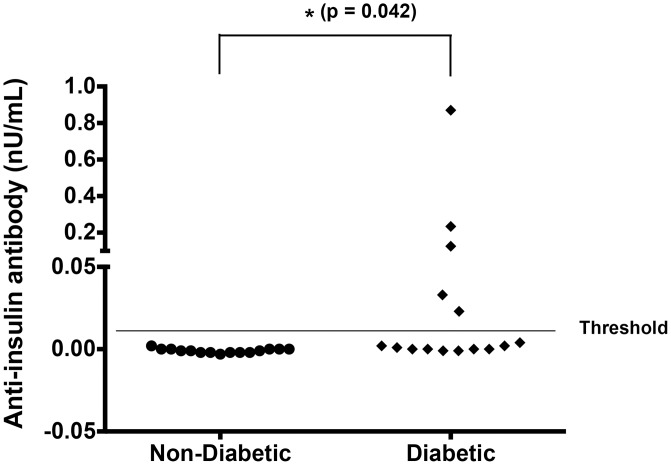
Anti-insulin antibodies in diabetic and non-diabetic dogs.Anti-insulin antibodies were measured using the microIAA radioassay. Scatter plot showing individual anti-insulin antibody concentrations (in nU/mL) for non-diabetic dogs and for diabetic dogs. The gray line at 0.01 nU/mL represents the upper threshold for negative results. The frequency of diabetic dogs with anti-insulin antibody above threshold was significantly different from that of the non-diabetic dogs (p = 0.042, Fisher’s exact test).